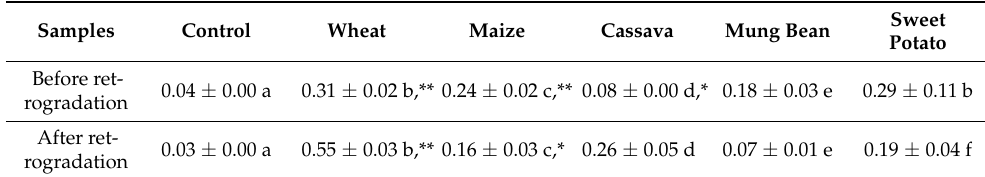
Table 1. Disulfide bond contents of alkali-soluble glutenin mixed with five amylopectins before and after retrogradation ( µ